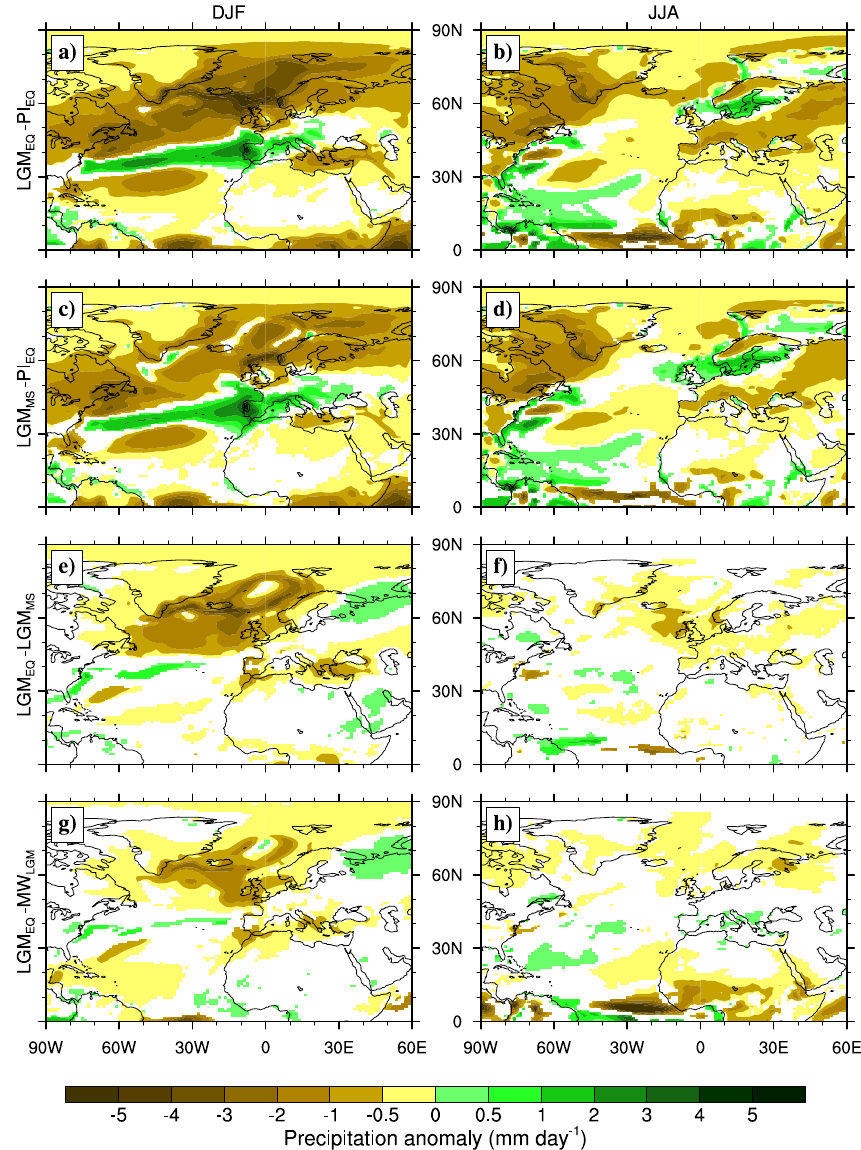
Fig. 6. Winter (DJF, left) and summer (JJA, right) precipitation anomalies for LGM EQ ( a and b ) and LGM MS ( c and d ) with respect to PI EQ , and the differences between LGM EQ and LGM MS ( e and f ) and LGM EQ and MW LGM ( g and h ). Only the values that are statistically significant at the 5% level based on the two-sided Student’s t-test are